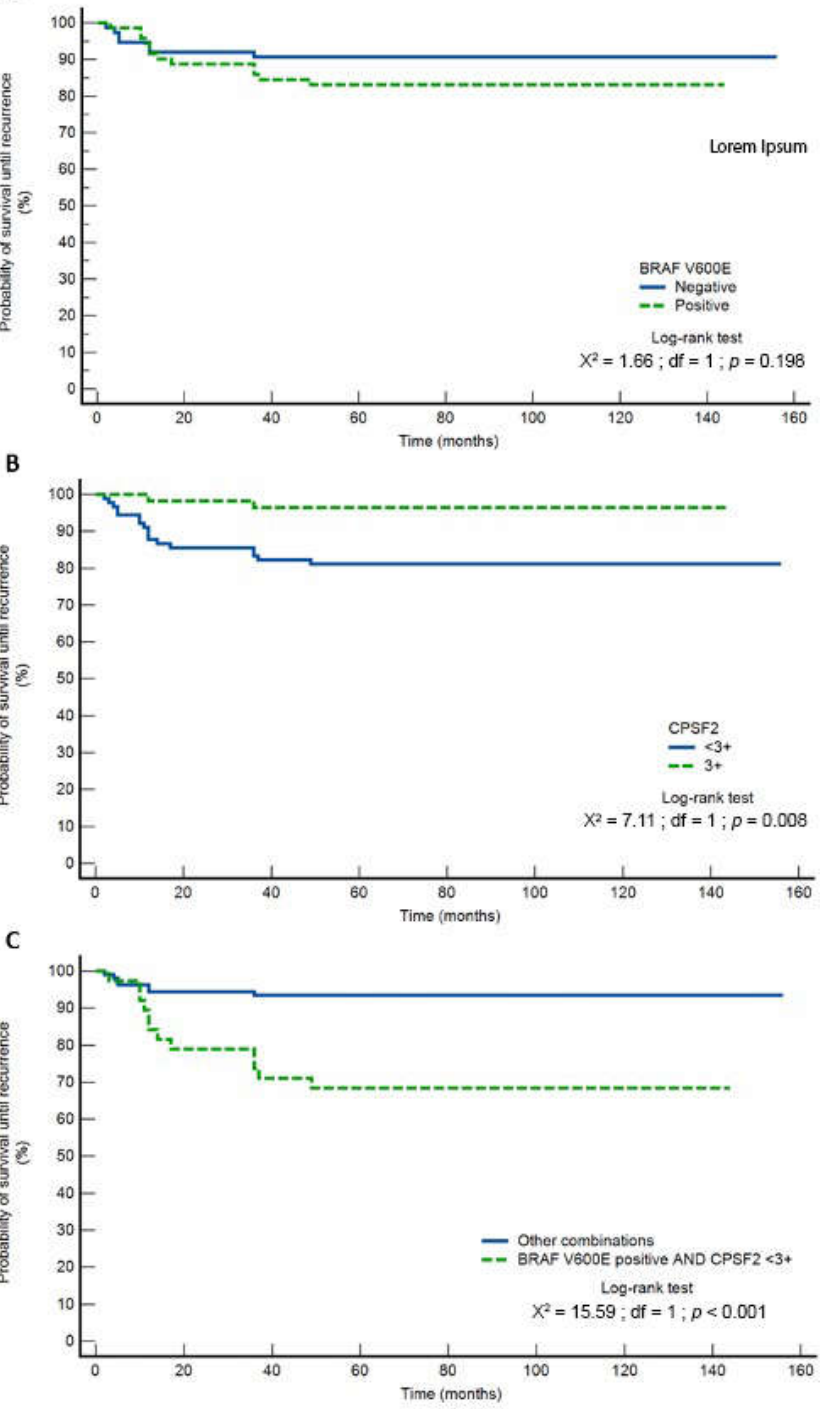
Figure 2. Kaplan–Meier survival curves for disease-free survival in correlation with BRAF (HR of 1.81 (95% CI: 0.73–4.47)) ( A ), CPSF2 groups (CPSF2 < 3+ group—HR of 3.49 (95% CI: 1.39–8.78)) ( B ), and their combination (HR of 8.32 (95% CI: 2.91–23.83)) ( C ).